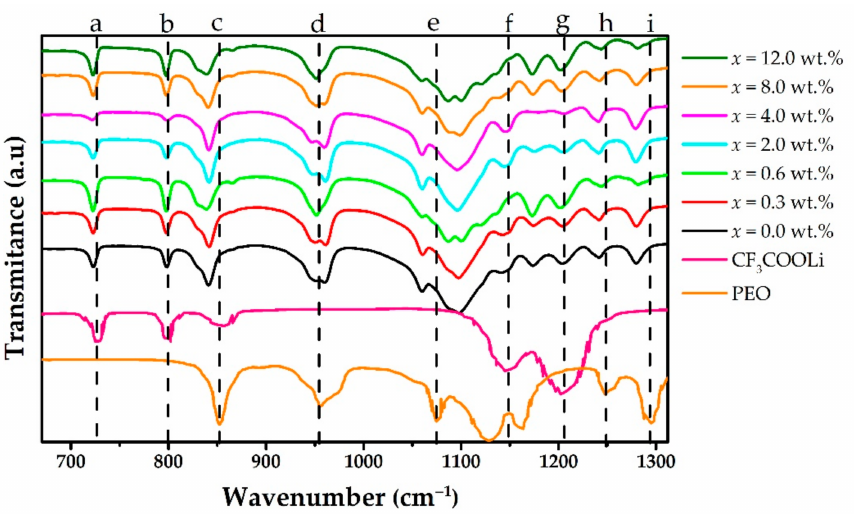
Figure 3. FTIR spectra for PEO, CF 3 COOLi, and different concentrations of MWCNT in the (PEO) 4 CF 3 COOLi electrolyte, for wavenumber ranging from 670 to 1312 cm − 1 . The dotted ver- tical lines stand for some wavenumber: a = 727 cm − 1 , b = 797 cm − 1 ; c = 857 cm − 1 ; d = 960 cm − 1 ; e = 1076 cm − 1 ; f = 1146 cm − 1 ; g = 1202 cm − 1 ; h = 1242 cm − 1 ; i = 1295 cm − 1